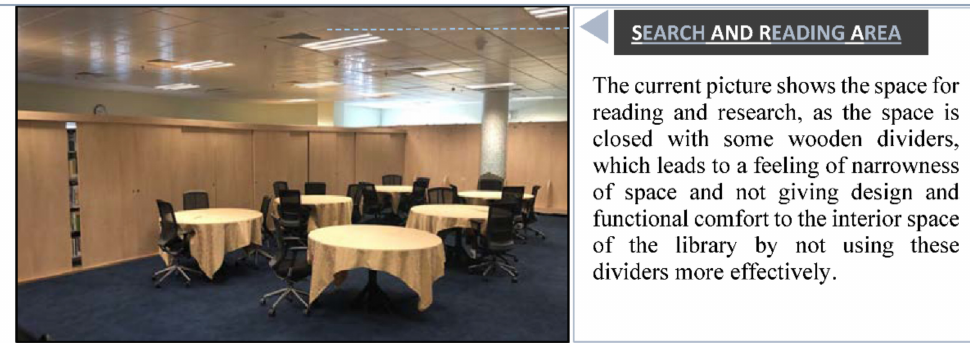
Figure 18. Shows the space for reading and